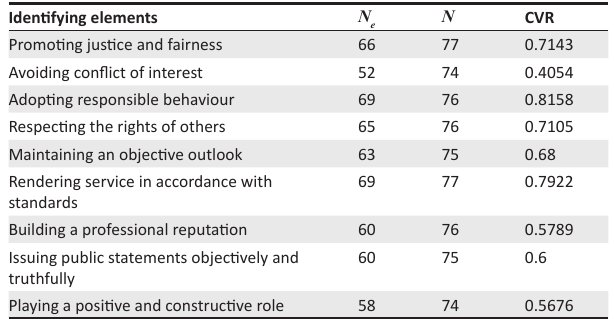
TABLE 14: Content Validity Ratio (Lawshe) of responsibility for personal work